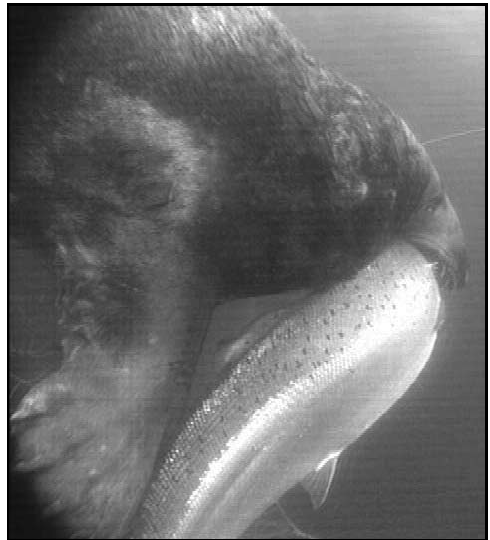
Fig. 1. Caught in